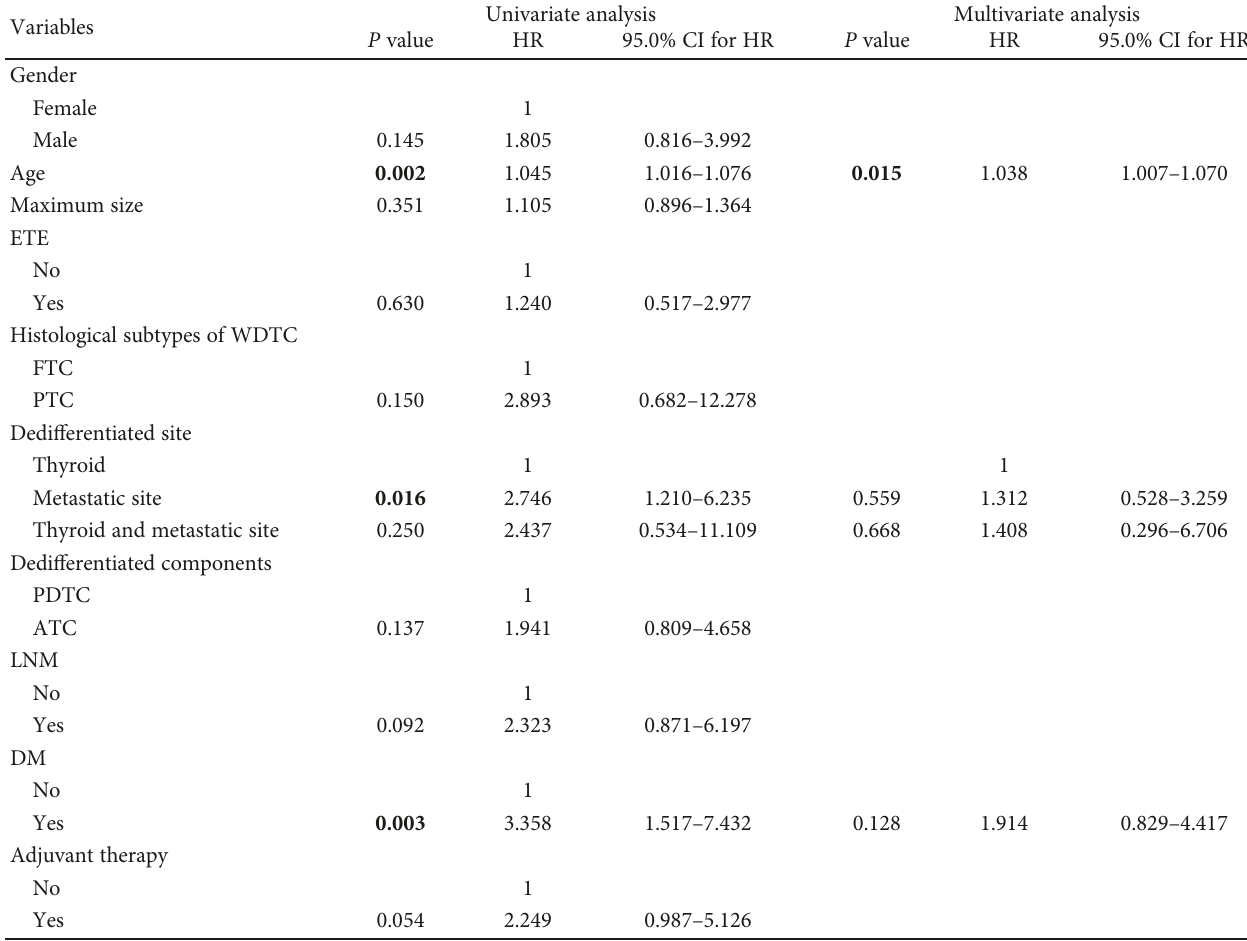
Bold type indicates statistical signi fi cance. WDTC: well-di ff erentiated thyroid cancer; HR: hazard ratio; CI: con fi dence interval; ETE: extrathyroidal extension; FTC: follicular thyroid cancer; PTC: papillary thyroid cancer; PDTC: poorly di ff erentiated thyroid cancer; ATC: anaplastic thyroid cancer; LNM: lymph node metastasis; DM: distant